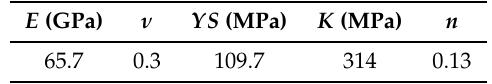
Figure 6. FE model including the meshed pre-cut sheet, backing plate and forming tool. Table 1. Mechanical properties for AA7075-O